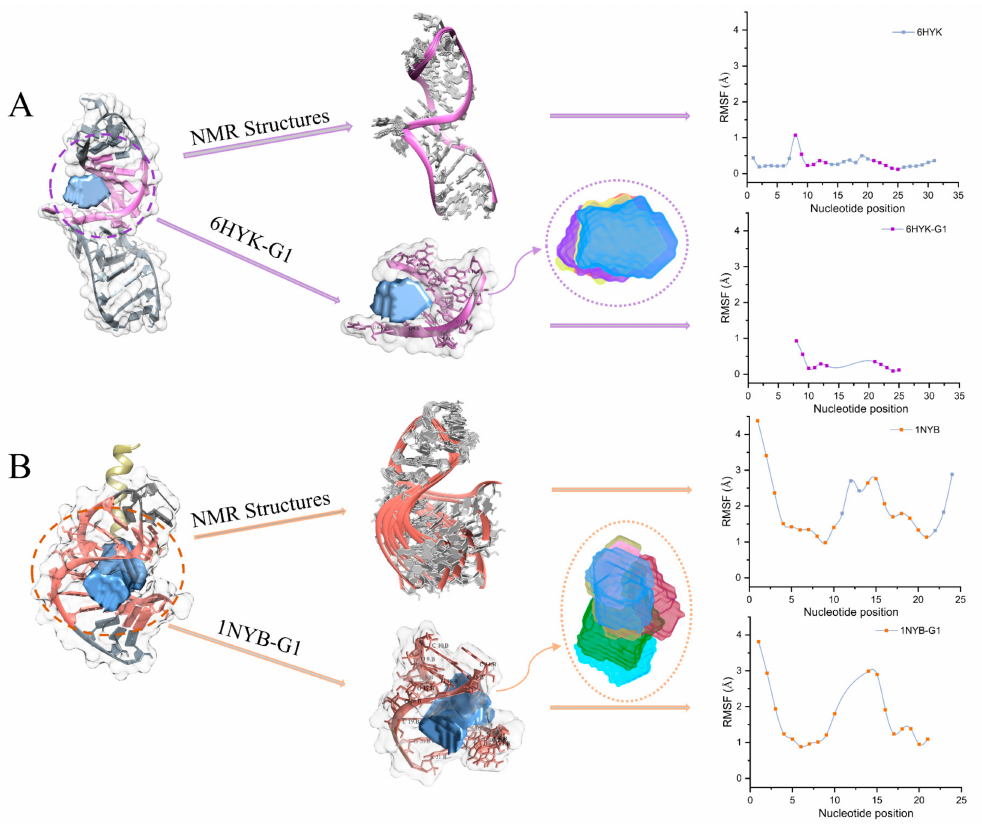
Figure 2. Examples of pocket flexibility reflect structural flexibility. ( A ) Conformational changes and calculations of RMSF for structure (PDB code: 6HYK) and pockets (6HYK-G1). The purple marker dots indicate the overlapping nucleotides forming the pockets in 6HYK-G1. ( B ) Conformational changes and calculations of RMSF for structure (PDB code: 1NYB) and pockets (1NYB-G1). The orange marker dots indicate the overlapping nucleotides forming the pockets in 1NYB-G1.